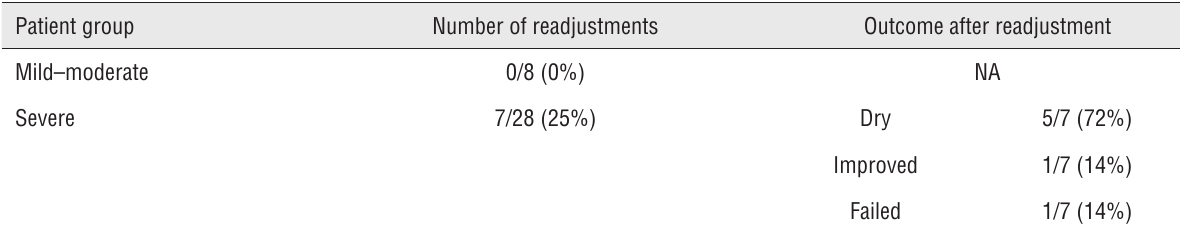
Table 4 - Readjustment of the Argus T device postoperatively. Patient